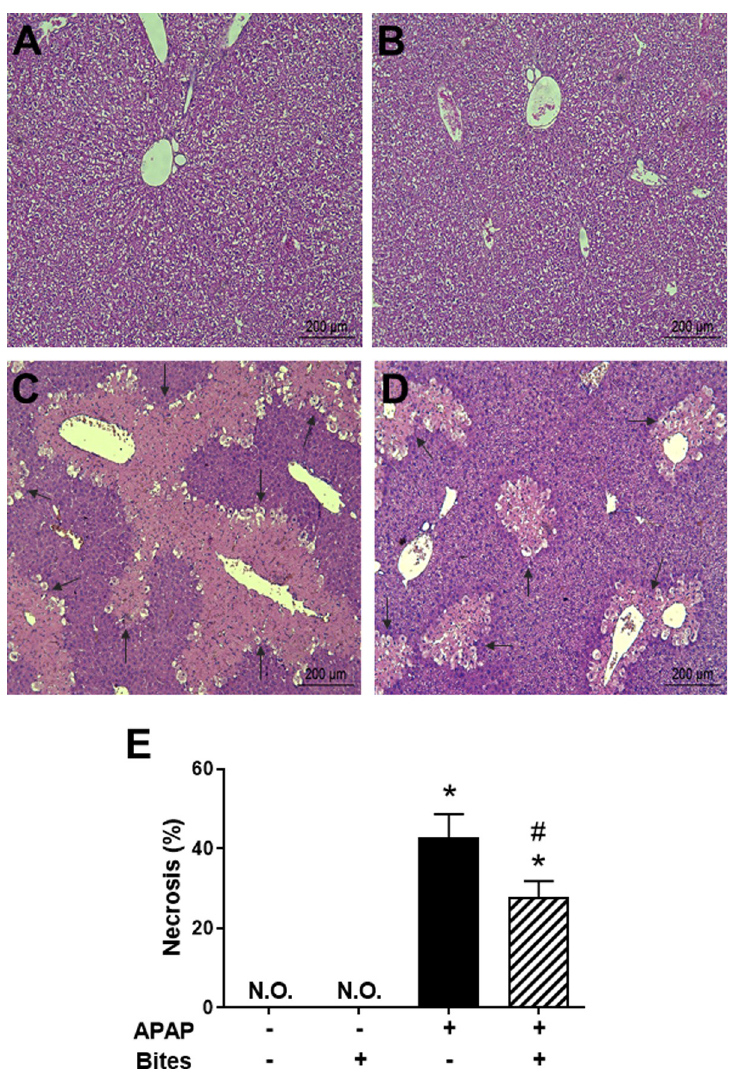
Fig 2. Liver histopathology of mice injected with APAP and exposed to Ae . aegypti bites. C57BL/6 male mice were injected with PBS or APAP (300 mg/kg i.p.) and, after 2 hours, exposed to 30 Ae . aegypti mosquitoes. Liver samples collected 24 hours after injection were assessed for the extent of damage caused by APAP overdose. A. “PBS” group; B. “PBS+Bites” group; C. “APAP” group; D. “APAP+Bites” group; E. Percentual of necrotic areas in the livers. Sections were analyzed at 100 × magnification. The arrows indicate necrotic areas. The data in E represent the mean ± SEM ( n = 6). � p < 0.05 versus “PBS” group; # p < 0.05 versus “APAP” group. N.O.: not observed. hepatotoxicity. Almost undetectable serum concentrations of TNF- α , IL-6, IL-1 β and IL-10 were observed in mice from “PBS” and “PBS+Bites” groups while APAP inoculation increased the concentration of all these cytokines. Mice exposed to Ae . aegypti bites following APAP injection produced significantly less TNF- α (Fig 4A), IL-6 (Fig 4B) and IL-10 (Fig 4D). Although the reduction of serum IL-1 β in “APAP+Bites” group did not reach statistical signifi- cance when compared to the “APAP” group, it was reduced by more than 50% (Fig 4C). Next, the frequency of major leukocyte populations in the liver of mice was determined by flow cytometry and compared among the experimental groups. The exposure to mosquito bites in PBS injected animals did not significantly change the percentage of any of the cell